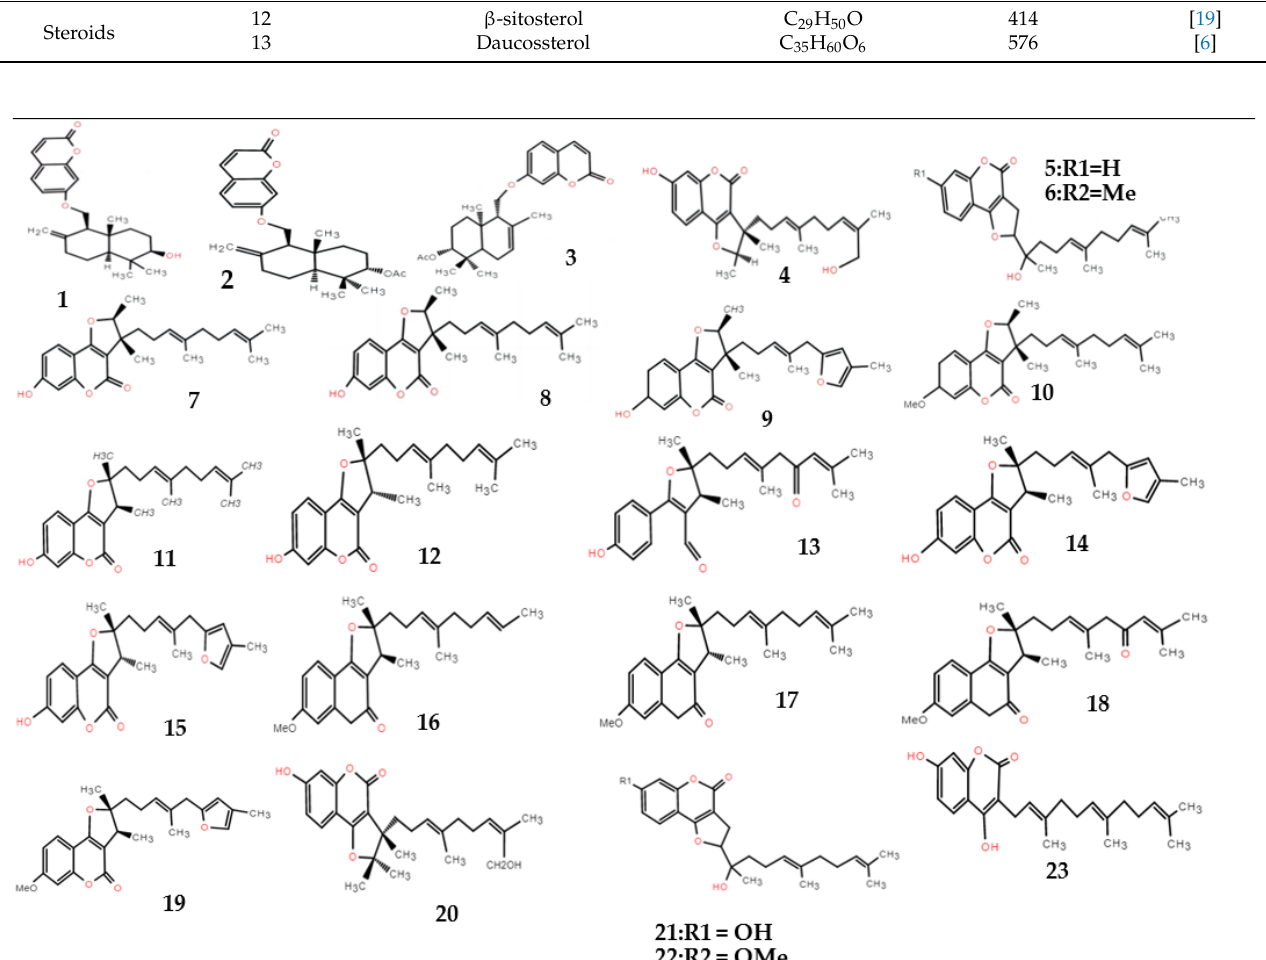
Figure 1. Structural diagram of sesquiterpene–coumarins of F . ferulaeoides.